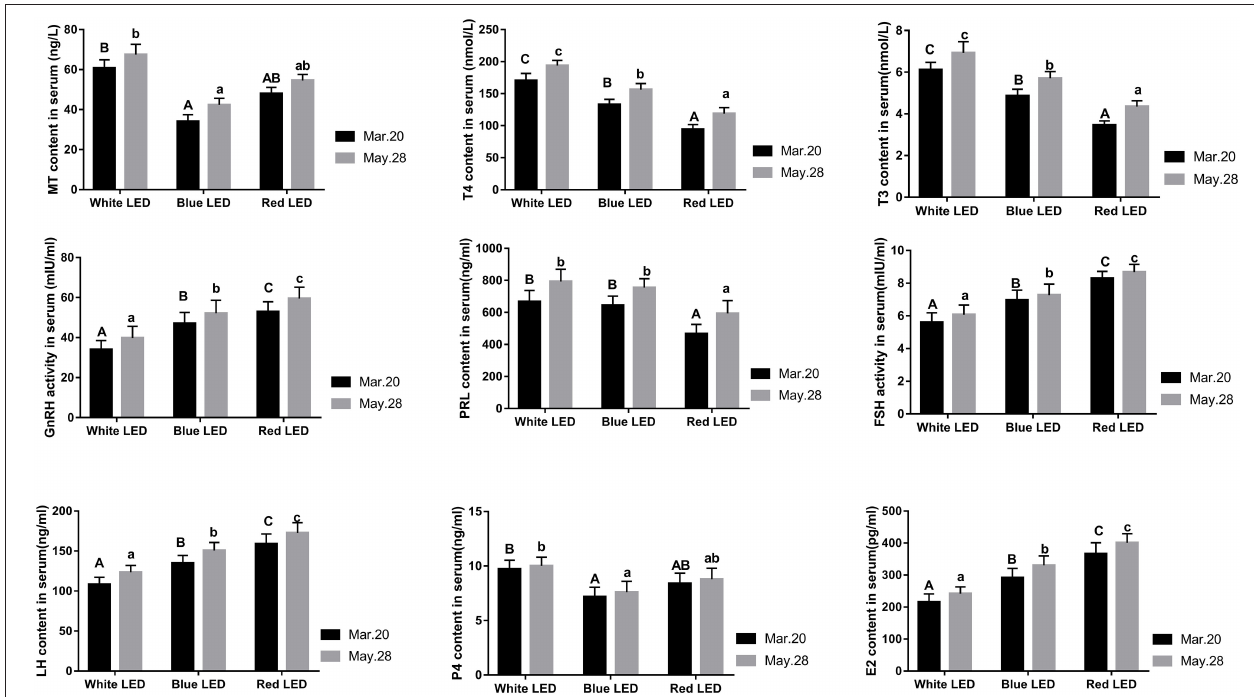
FIGURE 2 | Effects of different color LED illumination on serum hormone levels of Zi-goose. The columns containing different letters in the figure represent significant differences at 0.05 level. Capital letters indicate significant differences among the average egg-laying number, and small letters indicate significant differences among the average eligible egg-laying